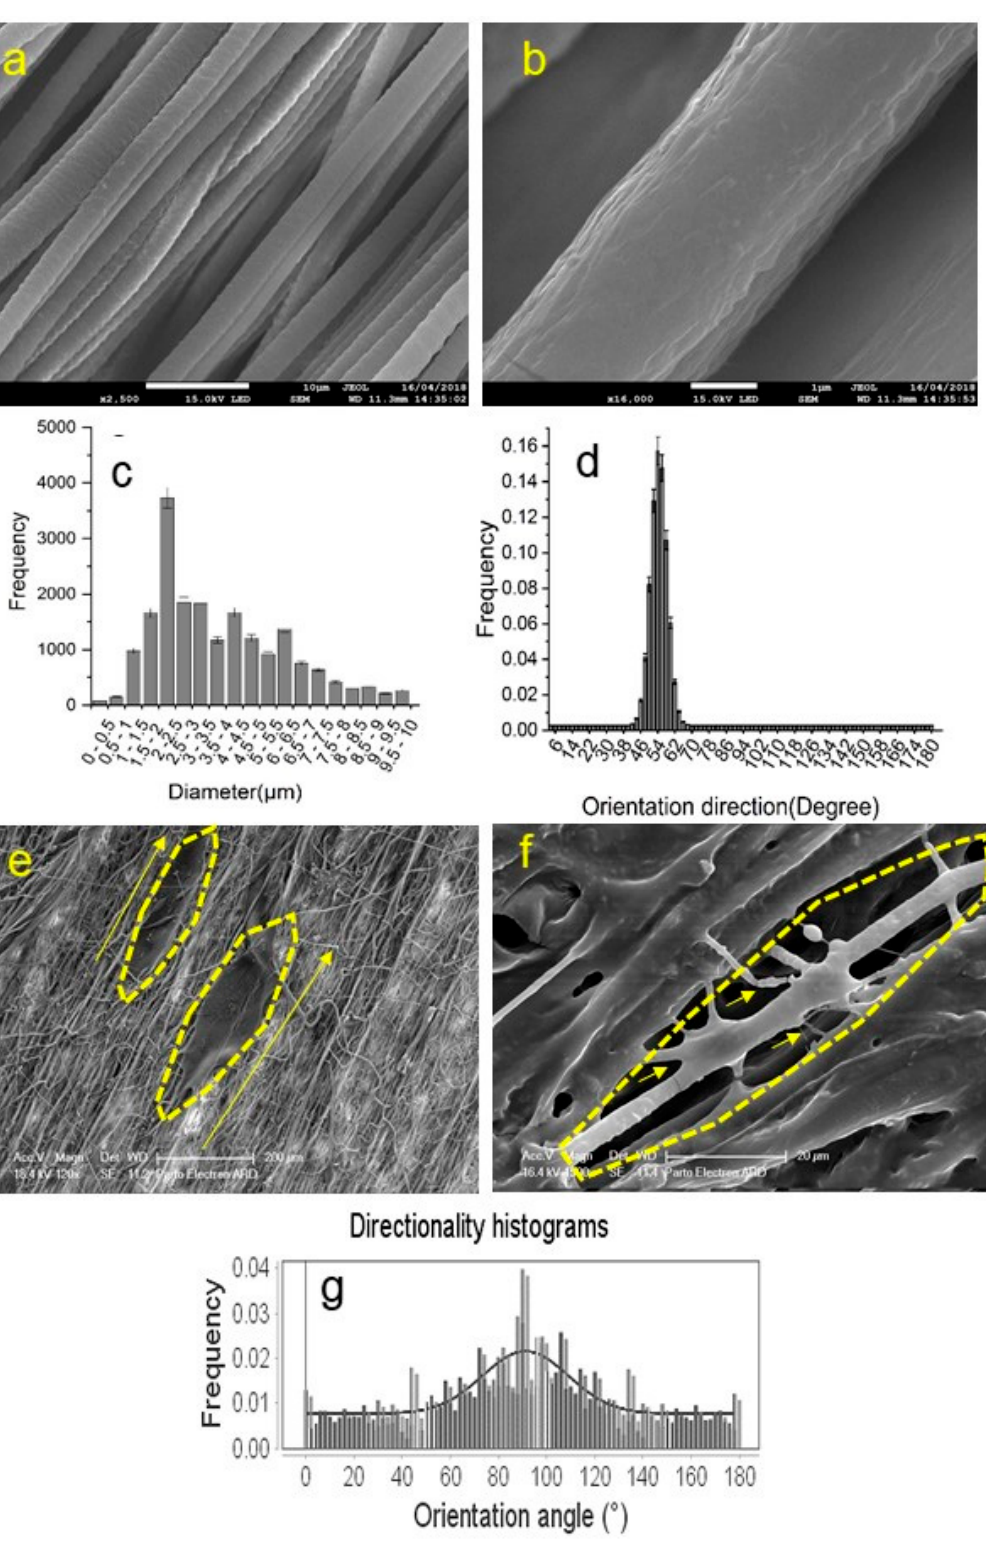
Figure 3. ( a ) SEM images of aligned fibrous scaffolds (scale bar: 10 µm); ( b ) SEM images of aligned fibrous scaffolds (scale bar: 1 µm); ( c ) the quantitative distribution of fibre diameters; ( d ) The orientation direction distribution of the scaffold fibres; ( e ) the SEM image of the neurons on the aligned scaffold (scale bar: 200 µ m); ( f ) the SEM image of the neurons on the aligned scaffold (scale bar: 20 µ m); and ( g ) the directional histogram of cells on the aligned scaffolds obtained by ImageJ ®